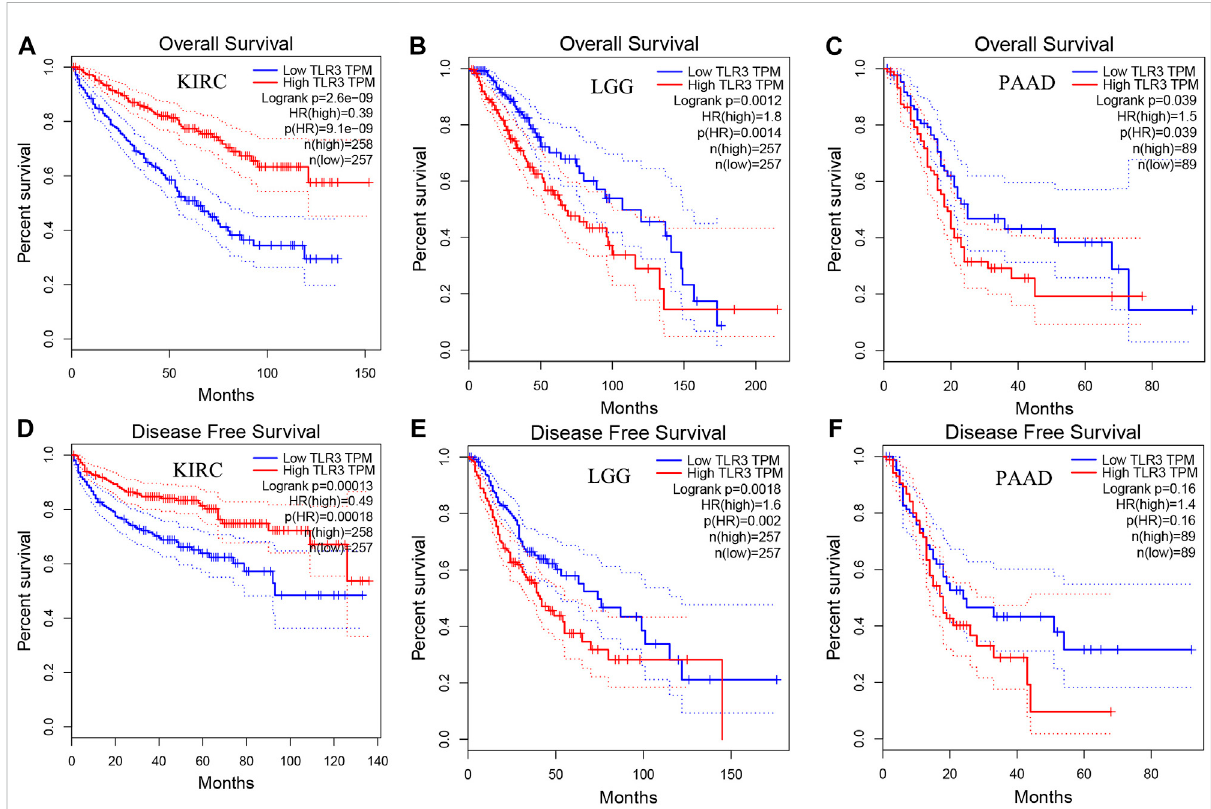
bene fi cial for prolonging DFS in LGG (Figure 2E), but TLR3 expression had no signi fi cant effect on DFS in PAAD (Figure 2F). In order to con fi rm the prognostic value of TLR3 expression in three kinds of tumors, we further investigated the associations of TLR3 expression with the prognosis of KIRC, LGG and PAAD by DriverDBv3. The results indicated that TLR3 overexpression was bene fi cial to prolong the OS (Figure 3A), platinum-free treatment interval (PFI) (Figure 3B) as well as disease speci fi c survival (DSS) (Figure 3C) of KIRC, while suppressed expression of TLR3 was bene fi cial for prolonging OS (Figure 3D), PFI (Figure 3E) and DSS (Figure 3F) of LGG. Moreover, suppressed expression of TLR3 was bene fi cial for prolonging OS (Figure 3G) and disease-free interval (DFI) (Figure 3H) of PAAD. Therefore, all these results demonstrated that TLR3 expression was associated with the prognosis of KIRC, LGG, and PAAD. Additionally, the expression of TLR3 exhibited different effects on the survival outcome of KIRC, LGG and